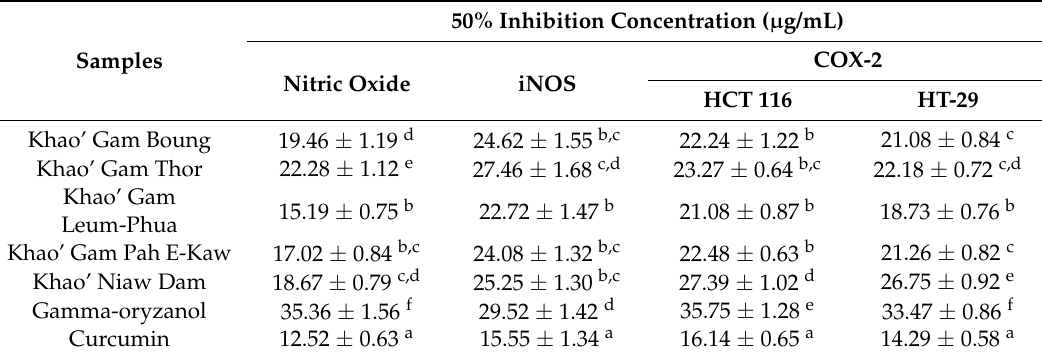
Table 2. Anti-inflammatory activities of